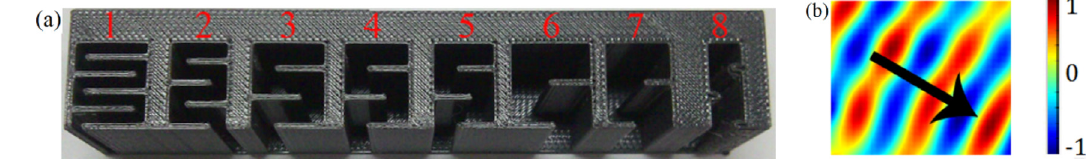
Fig. 1. (a) Photogragh of re fl ective type AMS. (b) Experimentally acoustic pressure- fi eld distribution [24].